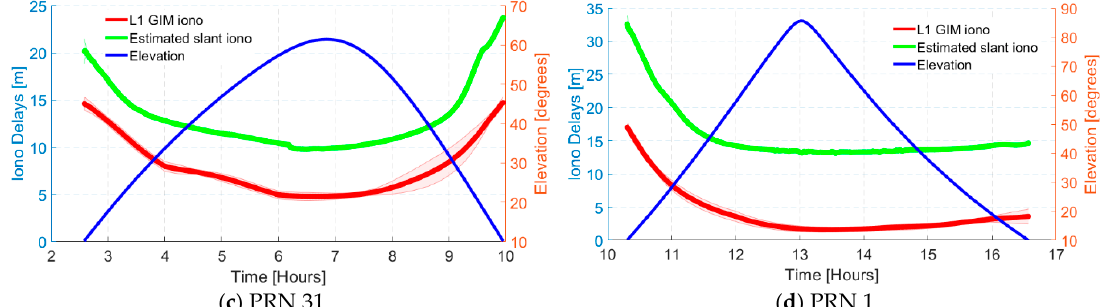
Figure 3. Magnitude of L1 GIM and estimated slant ionospheric delays for sample satellites with metre-level variations shown against satellite elevations. Delays are shown for DOY 253, 2018 for GMSD station, located in Japan. Bordered shaded colours represent the uncertainties.